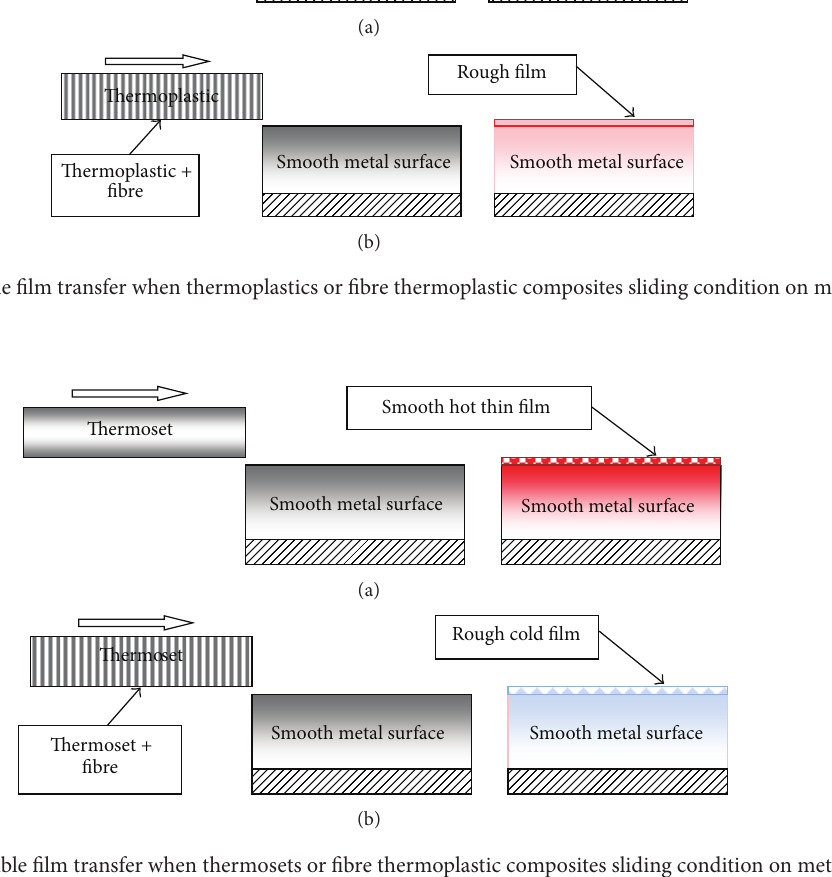
Figure 3: The possible film transfer when thermosets or fibre thermoplastic composites sliding condition on metal